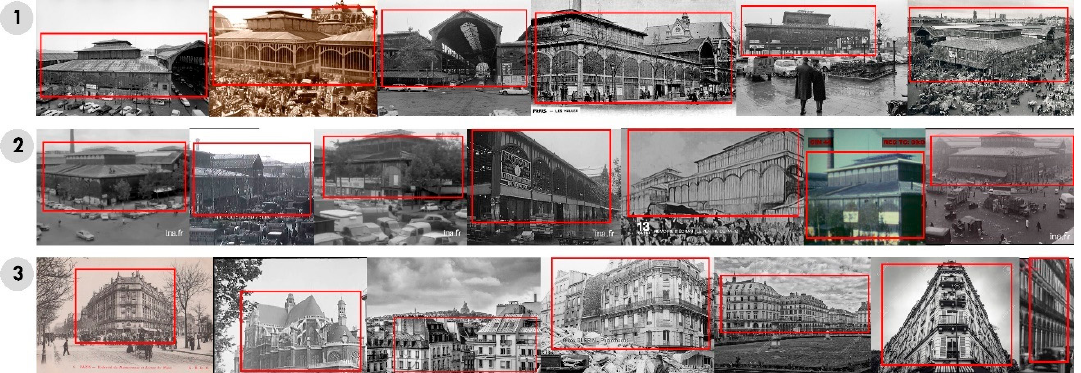
Figure 7. A selection of the pictures from the dataset 3 for Les Halles: ( 1 ) historical photographs; ( 2 ) historical images; ( 3 ) negative matching. Table 5. Description of the training and validation dataset 3 on the real case of Les Halles. Dataset